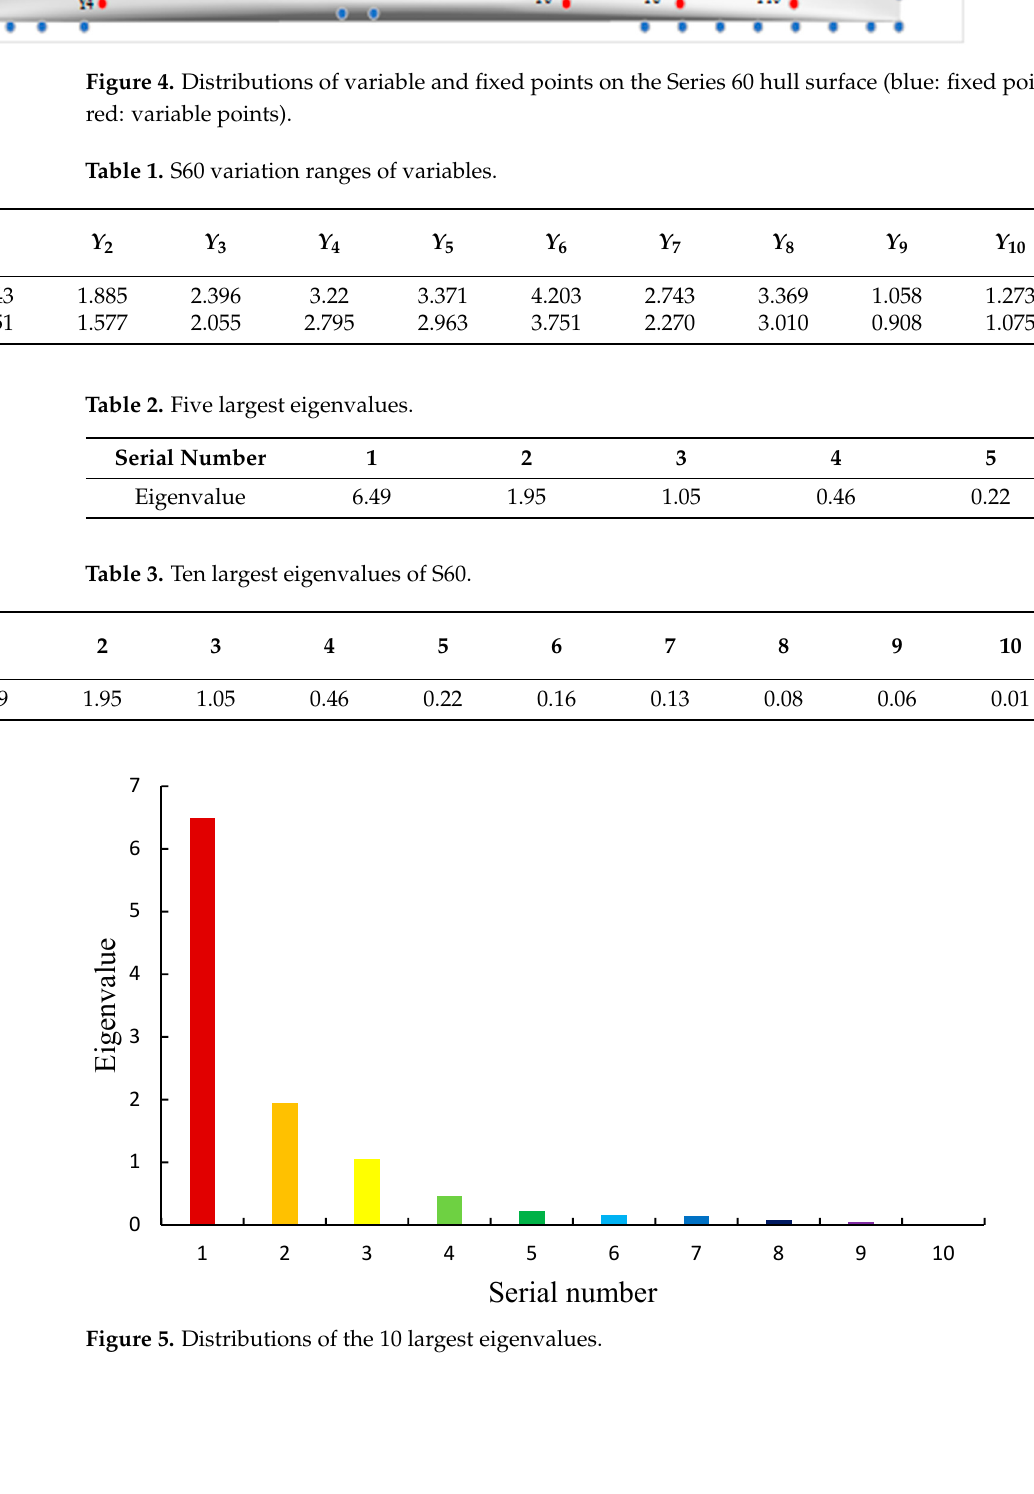
Figure 6. Contribution rates of the 10 largest eigenvalues. The hull surface was reconstructed by feeding a random set of new variables